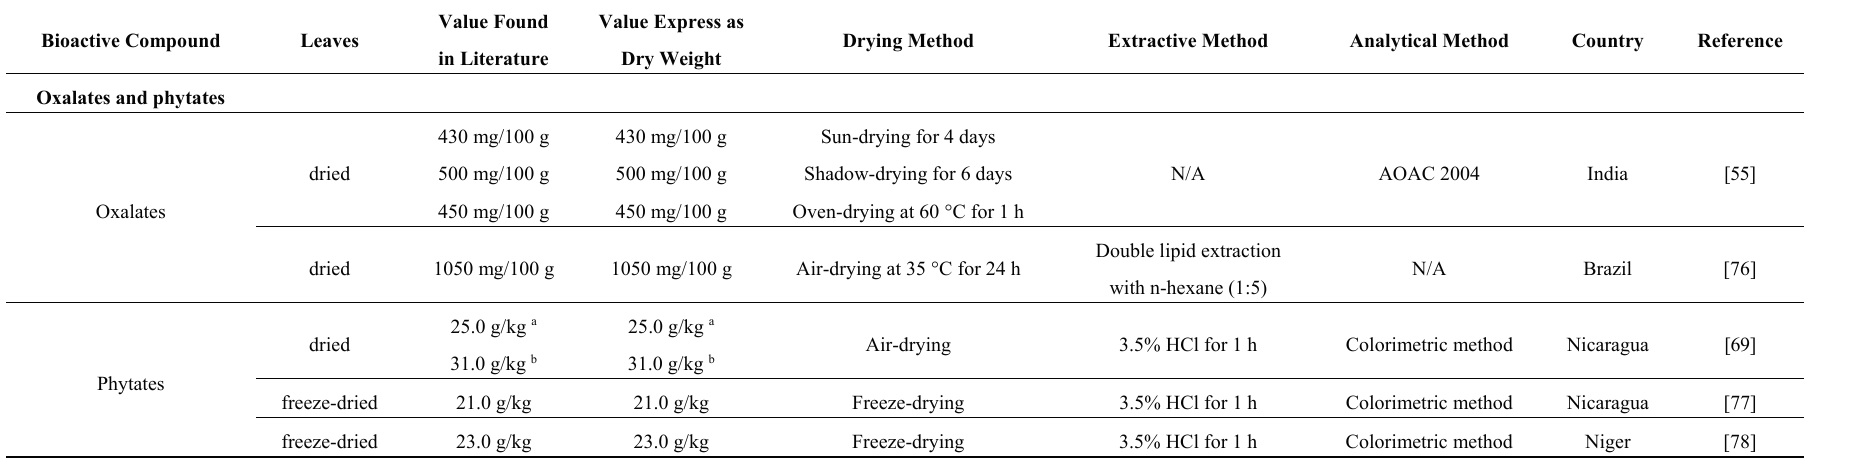
Table 9. Oxalates and phytates content in Moringa oleifera